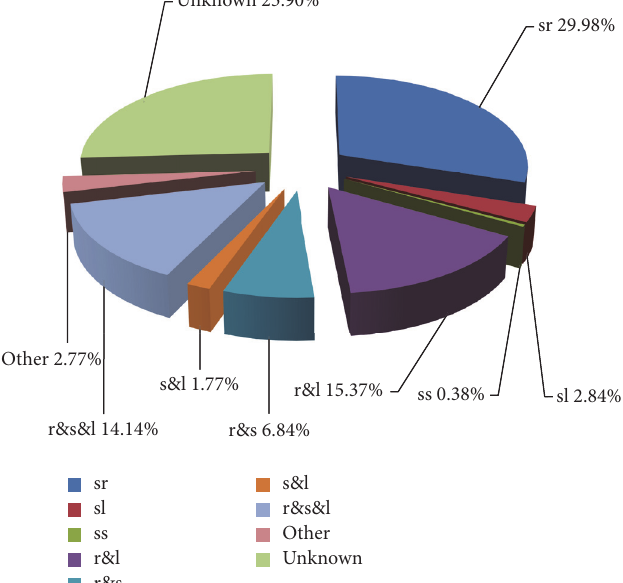
Figure 4: The percentages of expression patterns for differentially expressed genes. The percentages of expression patterns for the 3926 differentially expressed genes were shown in the pie chart. Basically, they were divided into nine types: (1) “sr” meant specifically expressing in roots; (2) “sl” meant specifically expressing in leaves; (3) “ss” meant specifically expressing in stems; (4) “r&l” indicated genes expressed in roots and leaves; (5) “r&s” indicated genes expressed in roots and stems; (6) “s&l” indicated genes expressed in stems and leaves; (7) “r&s&l” indicated genes expressed in roots, stems, and leaves; (8) “other” indicated genes expressed in other plant tissues; (9) “unknown” indicated genes which cannot identify their expression patterns in NCBI